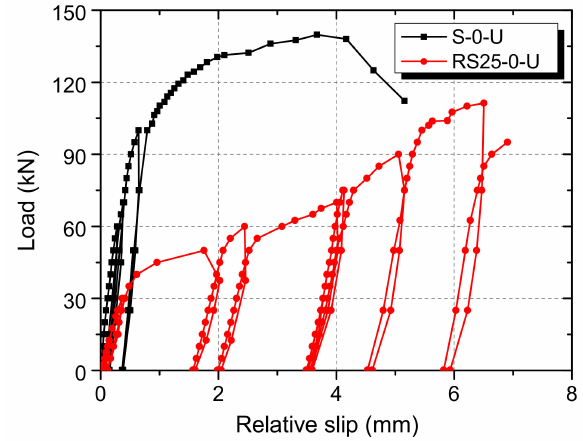
Figure 11. The load-slip curves of static push-out test